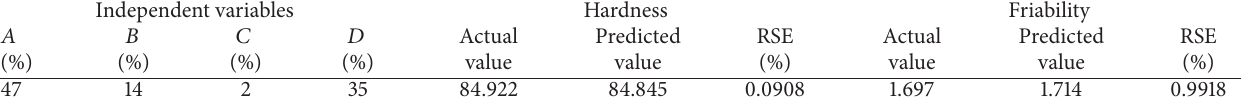
Table 5: Predicted and actual values of hardness and percentage of friability of optimal formulation.